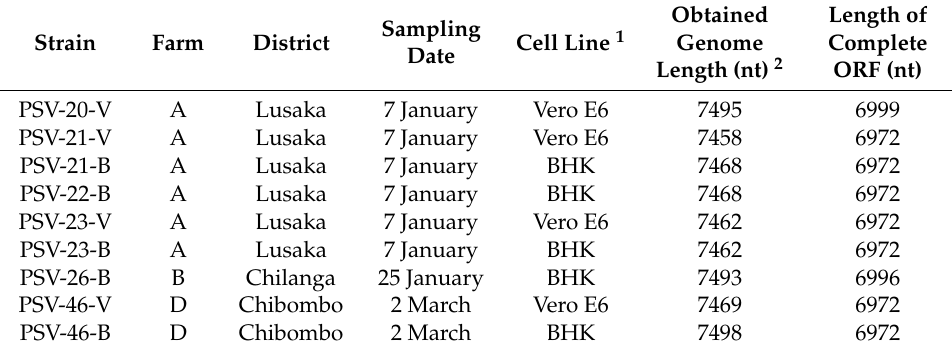
Length of Obtained Sampling Complete Genome Cell Line 1 Date ORF (nt) Length (nt) 2